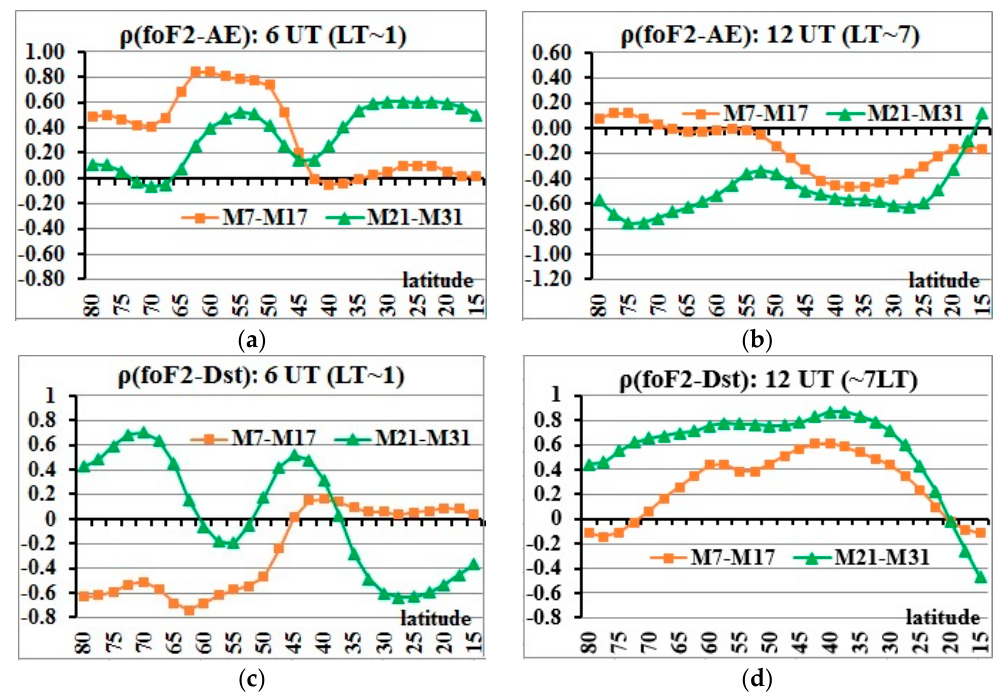
Figure 14. Examples of correlations between foF2(rec) and Space Weather (SW) parameters at the particular hours. Orange curve stands for 7–17 March, and green curve for 21–31 March.